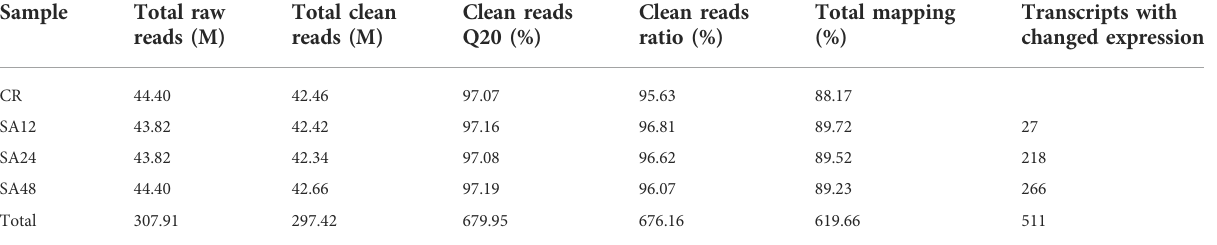
TABLE 2 Transcriptome raw data and differentially expressed